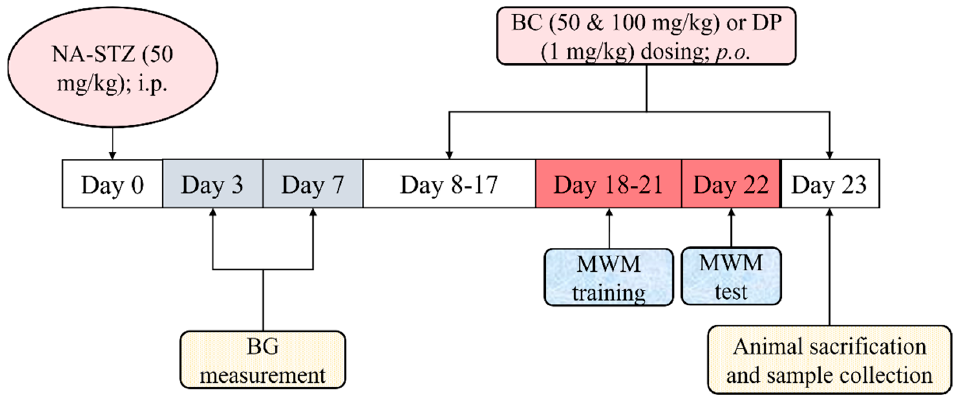
Figure 3. The experimental protocol. VaD was induced by NA and STZ injection on day 0. The blood glucose levels were measured on day 3 and day 7. BC and DP were administered from day 8 to day 23. The MWM training (learning phase) was conducted from day 18 to day 21. The MWM test (retrieval phase) was conducted on day 22. All the animals were sacrificed on day 23. Abbreviations: NA, nicotinamide; STZ, streptozotocin; BC, beta-carotene. DP, donepezil; BG, blood glucose; EPM, elevated plus maze; i.p. , intraperitoneal, p.o. , per oral; mg/kg, milligram per kilogram.